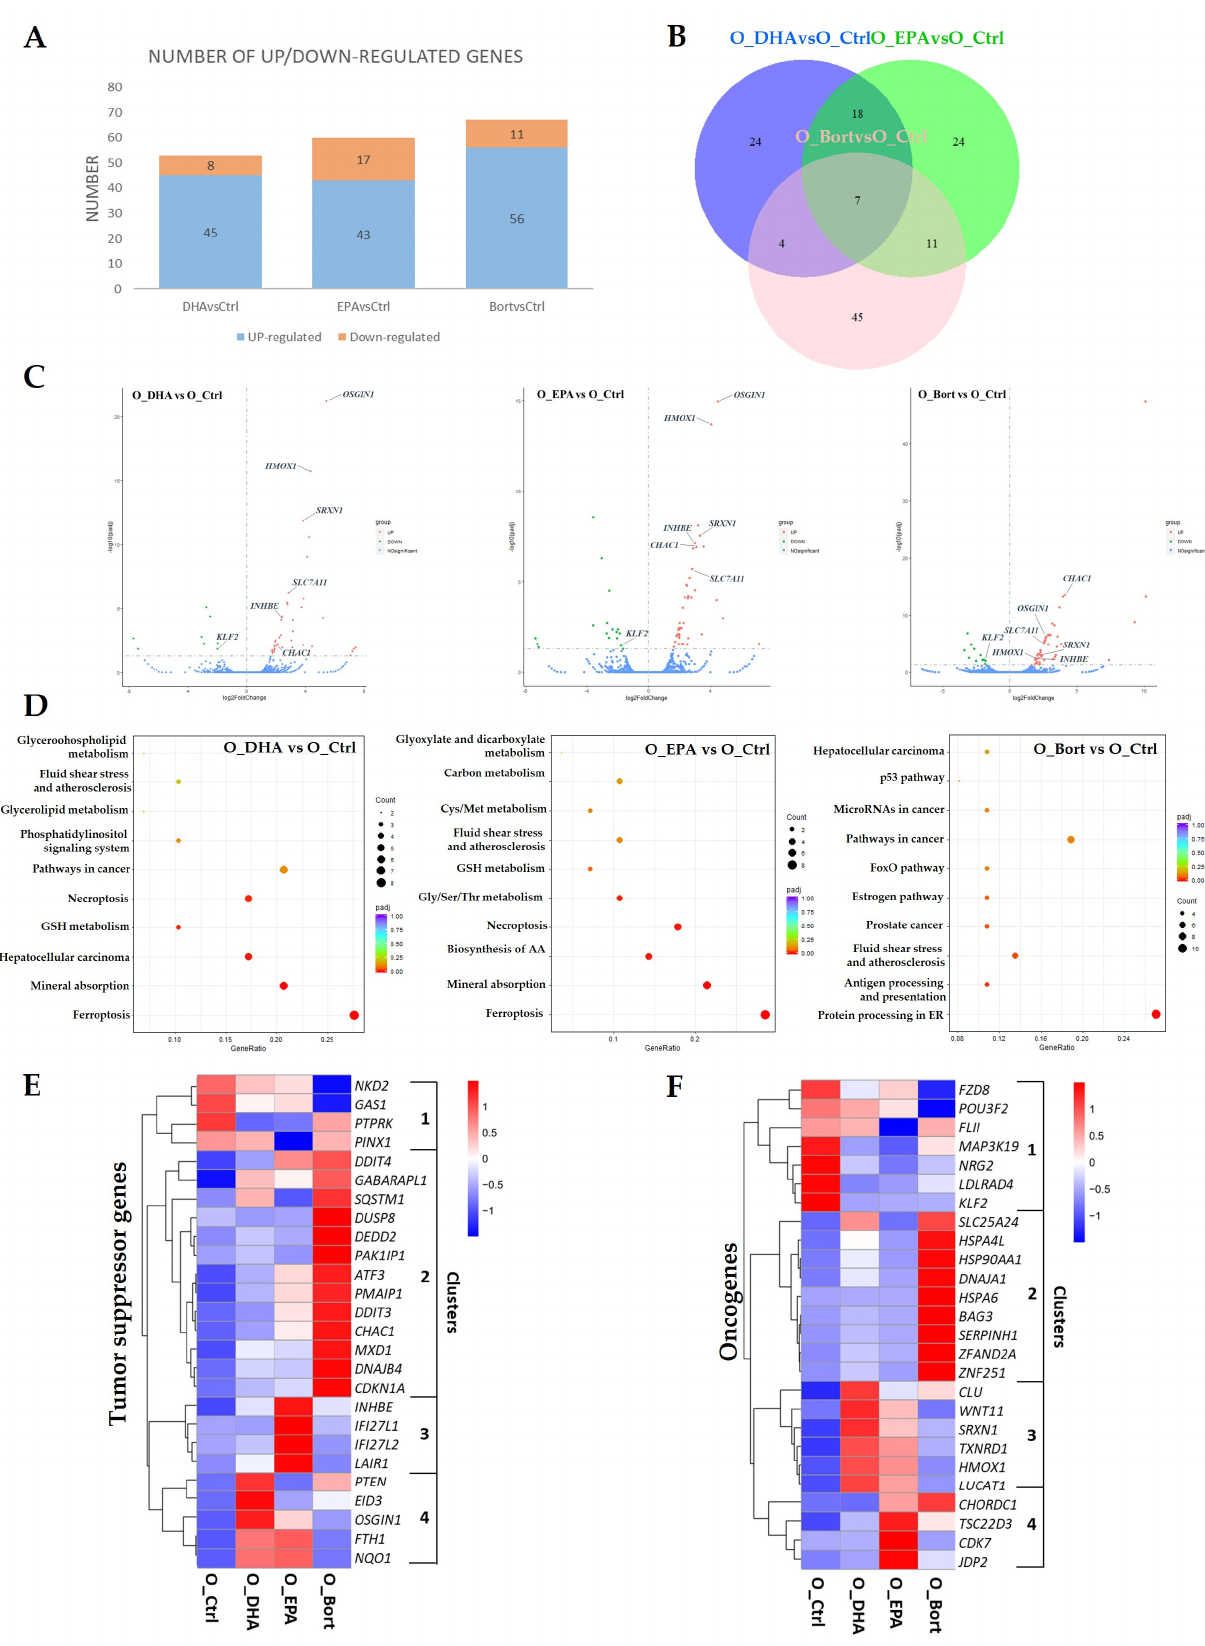
Figure 1. Transcriptomic profiling in response to DHA, EPA, or bortezomib in the OPM2 cell line. Cells were treated with 50 µ M of DHA/EPA (6 h) or 10 nM of bortezomib (4 h), and then RNA-seq analysis were performed. ( A ) Number of significantly